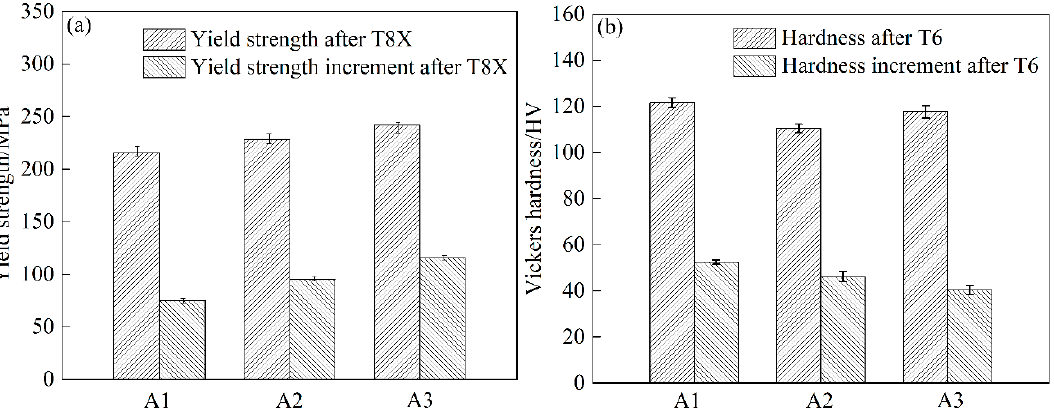
Figure 12. Yield strength and hardness increment of alloys after T8X and T6 treatment: ( a ) yield strength and ( b ) Vickers hardness.